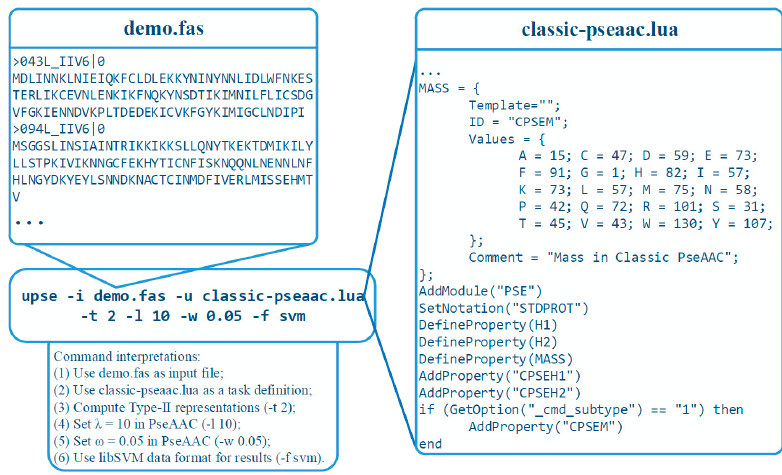
Figure 4. An example on using UltraPse. UltraPse was used to implement classic pseudo-amino acid compositions. A TDF: classic-pseaac.lua, was applied. The FASTA format sequences are stored in the demo.fas file. The command options indicate that the Type 2 PseAAC will be computed with the parameters: λ = 10 and ω = 0.05. The output format is compatible to libSVM.